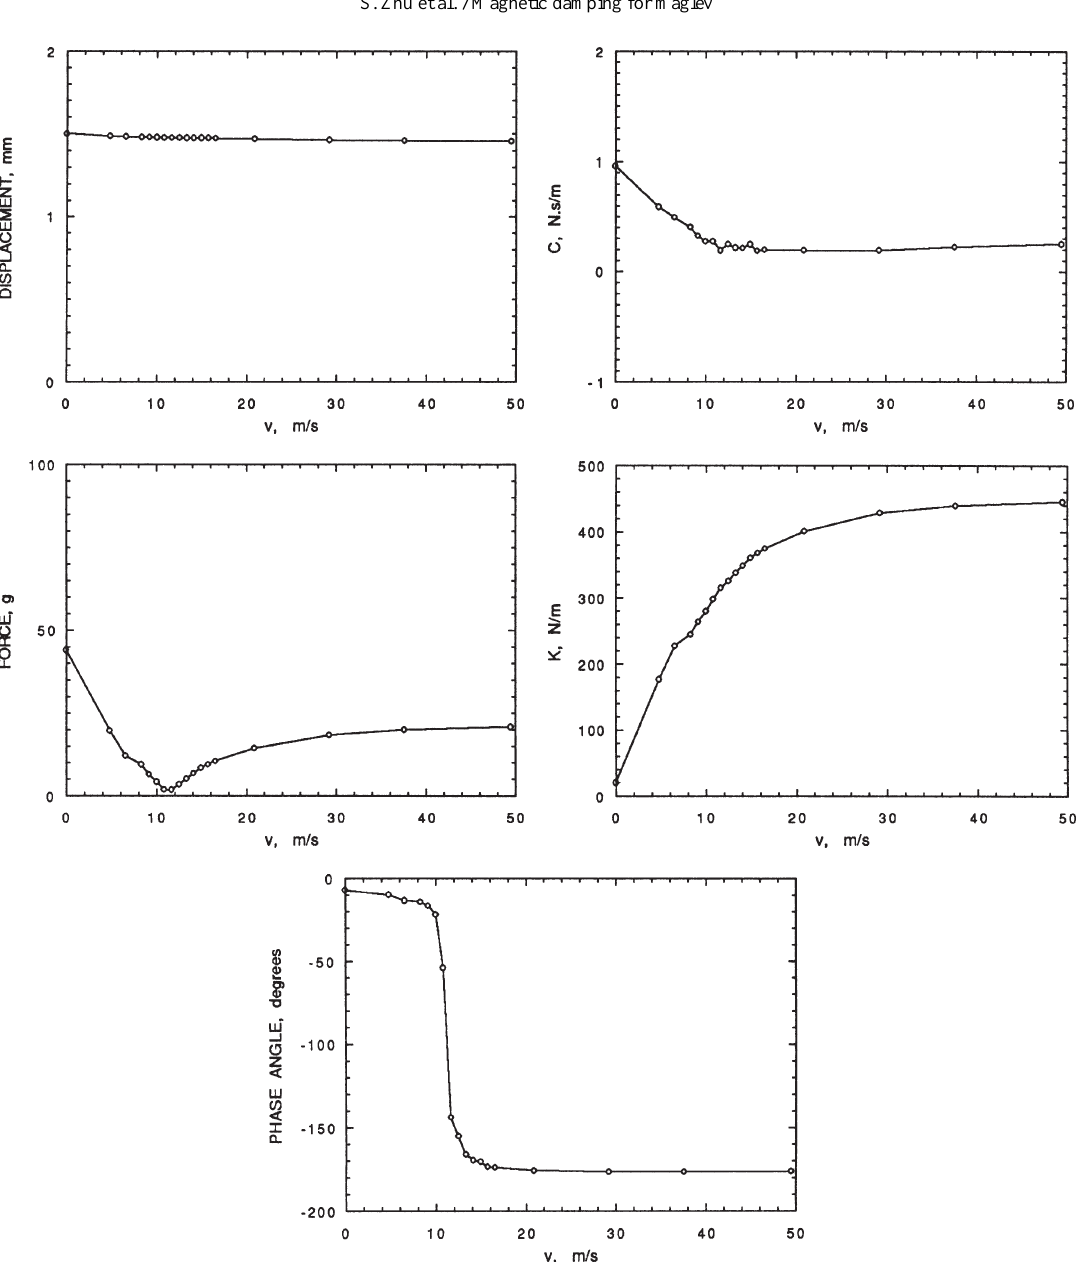
Fig. 4. RMS displacement and force, phase angle, and magnetic damping and stiffness excited at 6 Hz, test